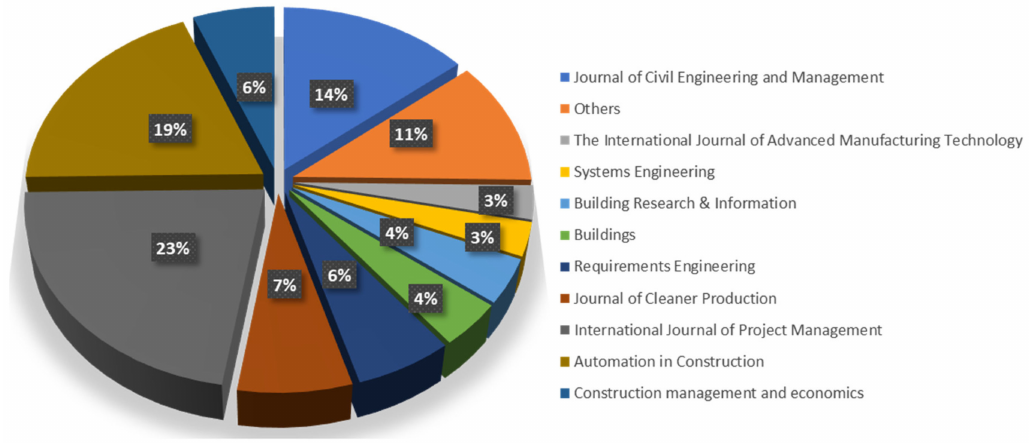
Figure 4. Summary of Journal Resources for study.